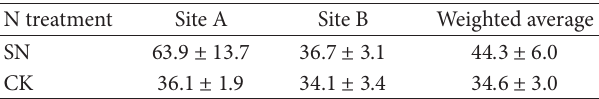
Table3:AnnualcumulativeemissionsofN N ha −1